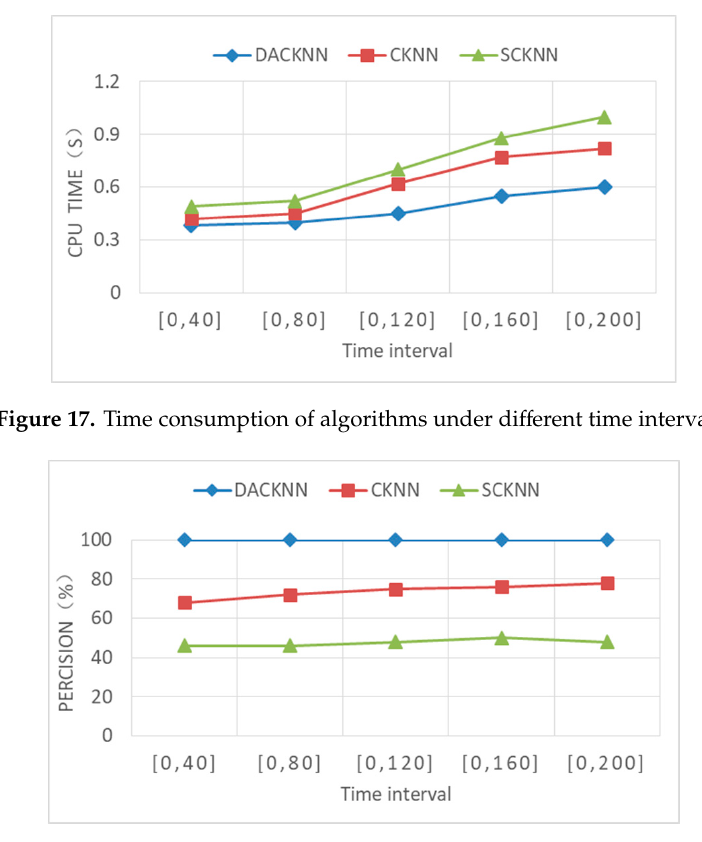
Figure 19. Time consumption of Algorithms for different K values.